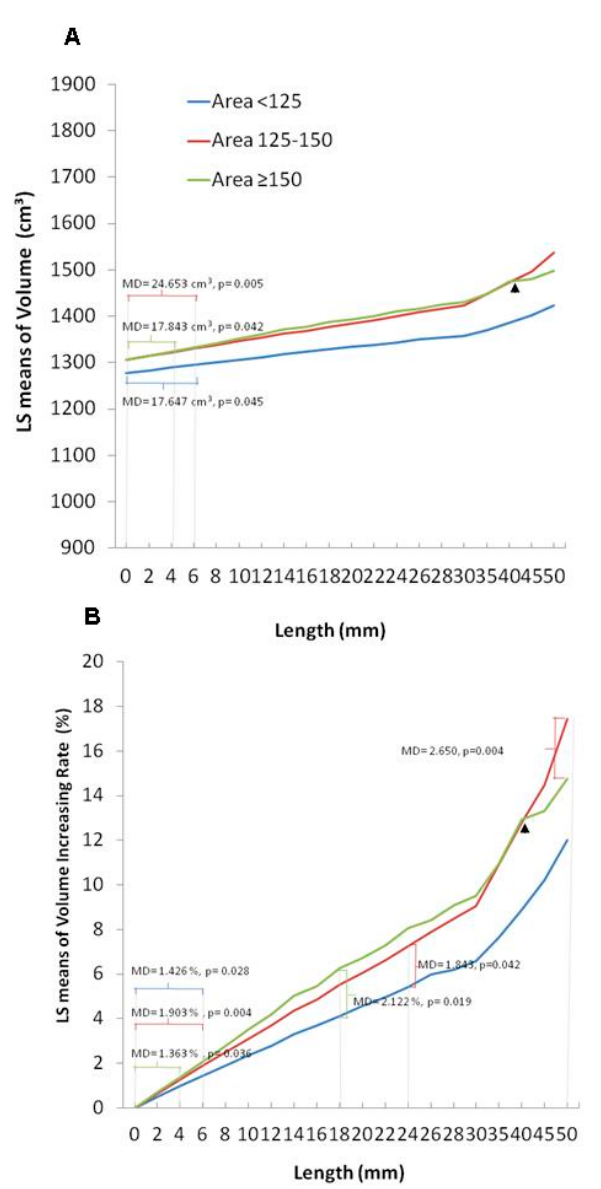
Figure 7. Estimated marginal means of volume ( A ) and volume-increasing rate ( B ) classified by area group in patients with contour elevation from 0 to 50 mm. LS: least squares; MD: mean difference.